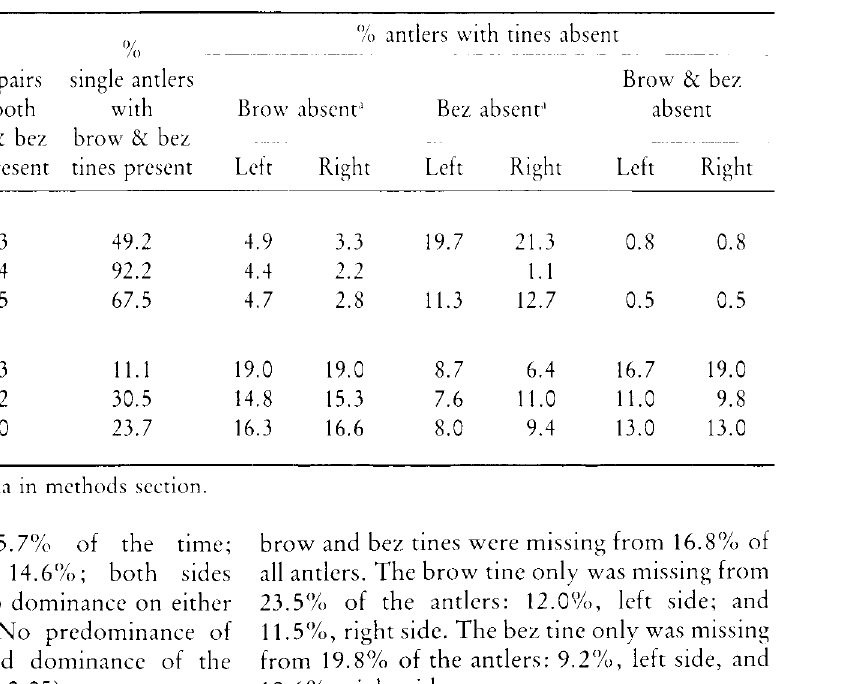
Table 2. Percentage distribution of 574 antlers from barren-ground caribou by presence of the brow and bez tines and absence of the brow or the bez tine, Northwest Territories, 1966-68.